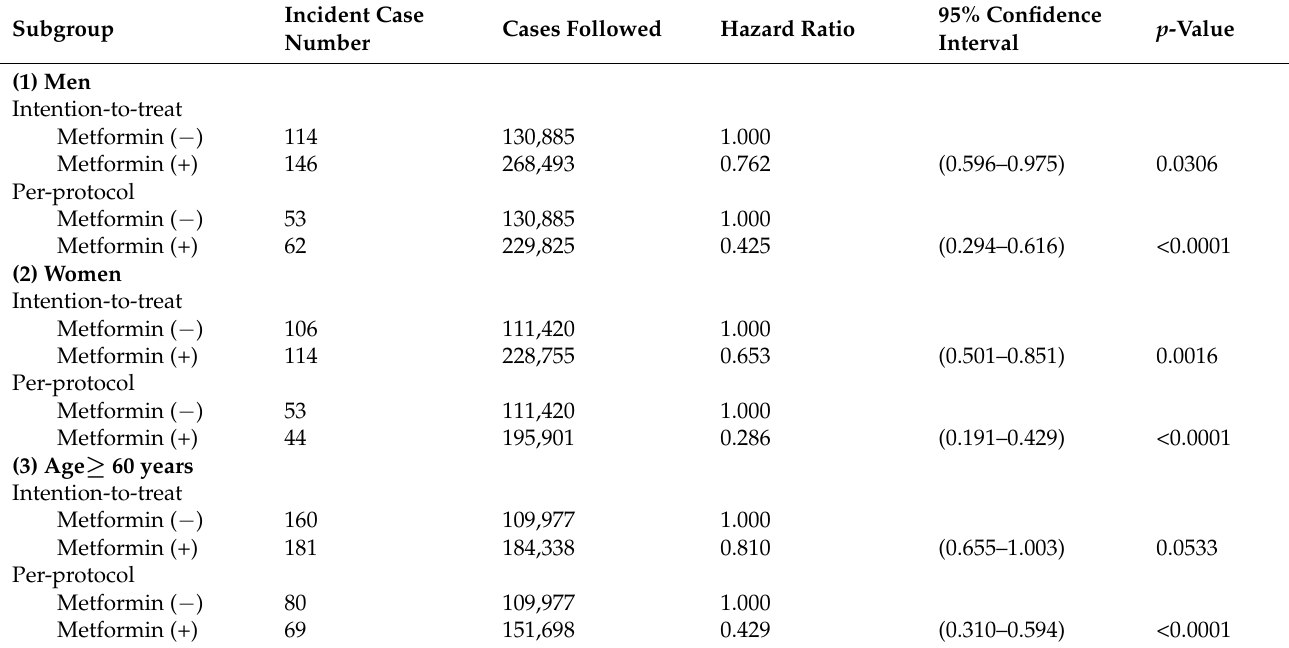
Table 3. Subgroup analyses by age and